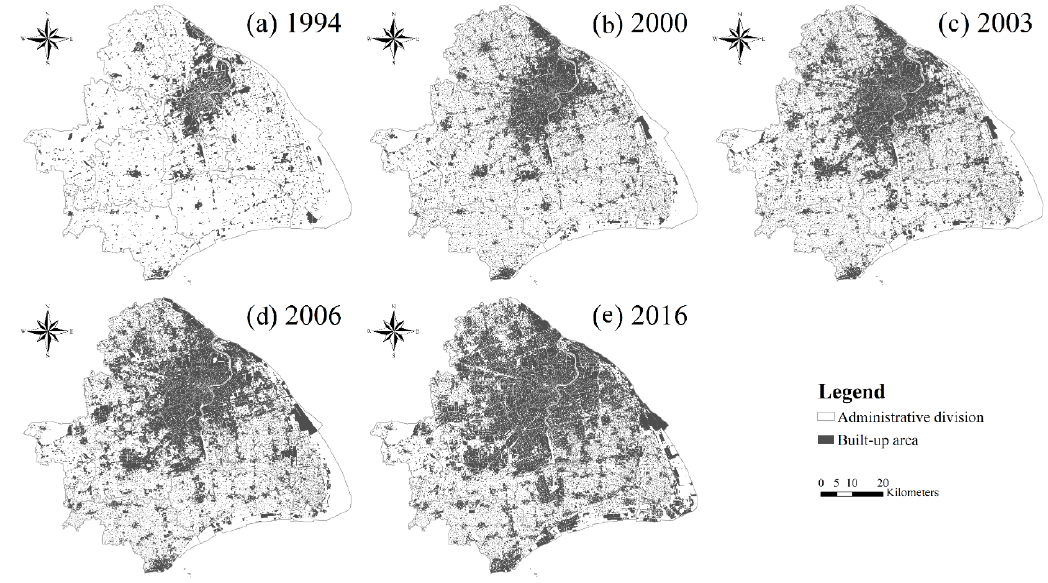
Figure 2. Spatial distribution of built-up land in Shanghai.